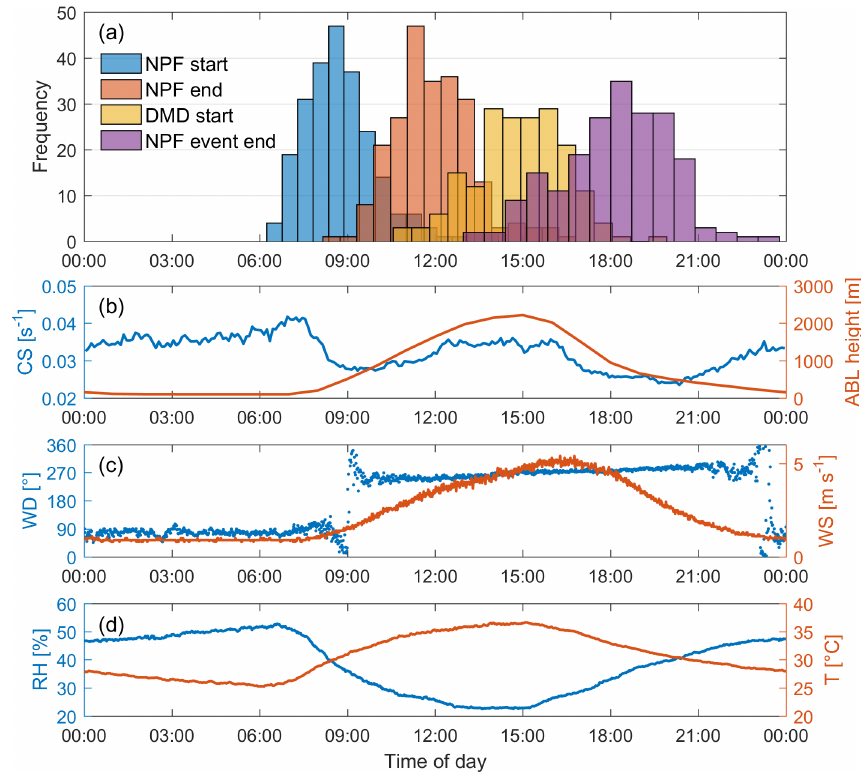
Figure 6. (a) Frequency histograms showing the temporal distribution of the different phases of the NPF events observed in Hada Al Sham (see Fig. 1) together with the median diurnal variation of (b) condensation sink and atmospheric boundary layer height, (c) wind direction and wind speed, and (d) relative humidity and